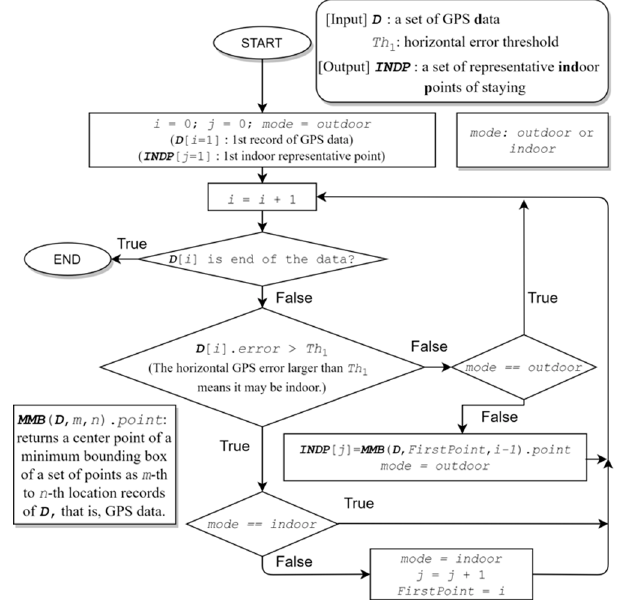
Figure 4. Algorithm for extracting a set of indoor location points from the trajectory data using GPS horizontal accuracy values.